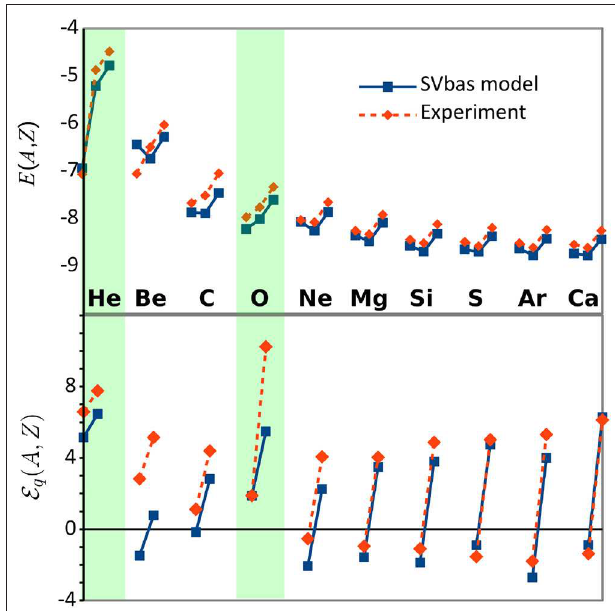
FIGURE 3 | Single particle energy and the corresponding energy differences are compared to experiments [ 40]. (Upper) For Z (8,4), (40,20), the binding energies E ( A , Z ), E ( A ··· shown by the connected lines in this order in each column. (Lower) The corresponding energy difference E n ( A , Z ) and E p ( A , Z ) for each nucleus Z A is shown by the connected lines in this order.